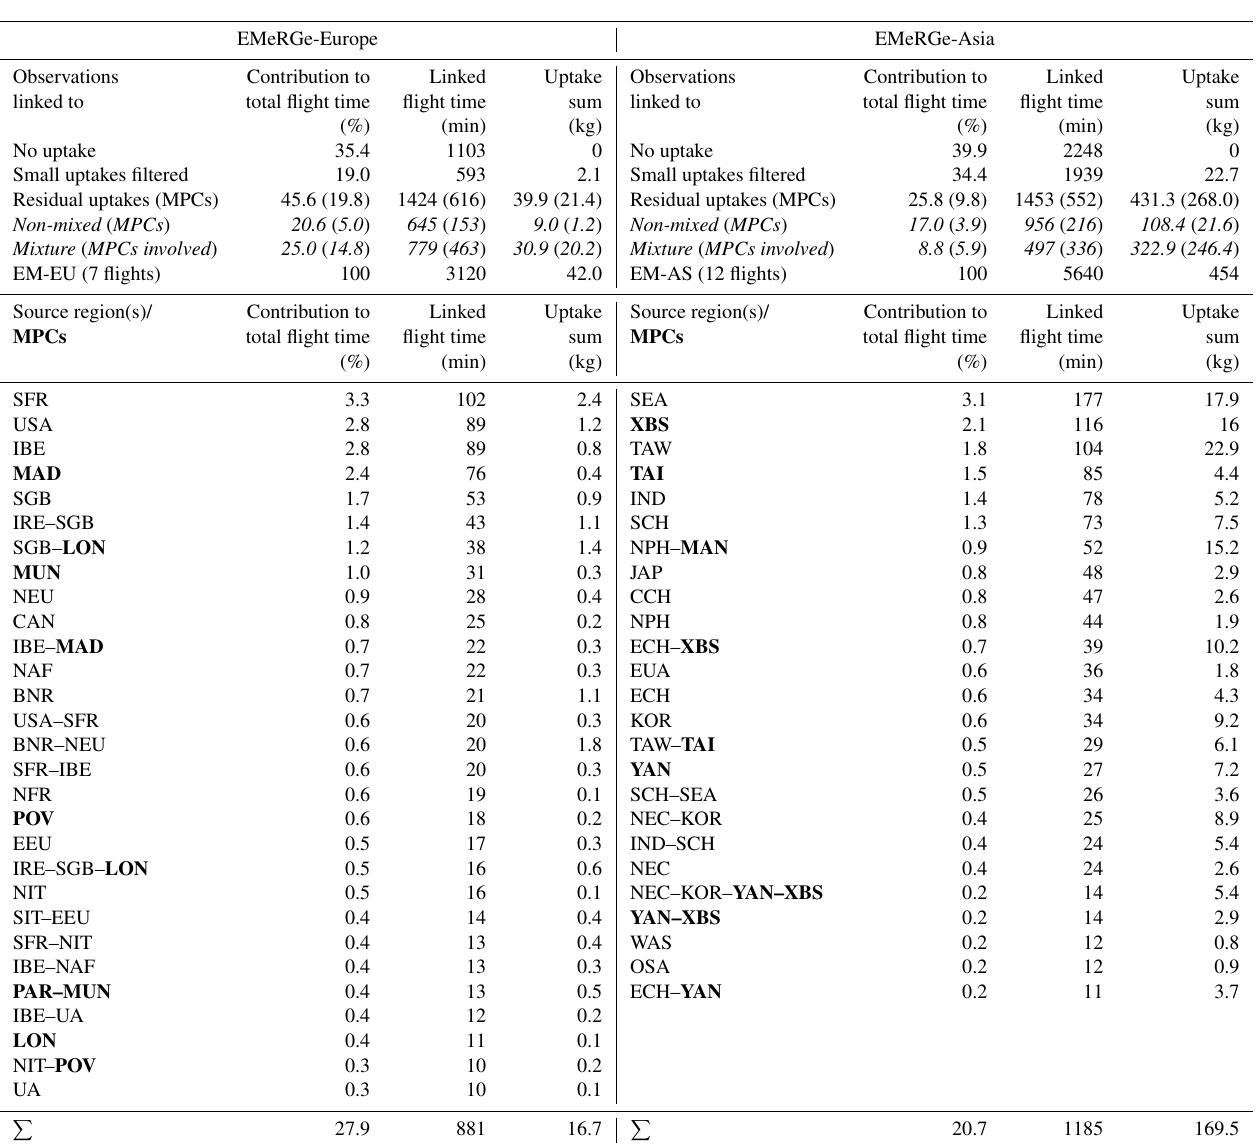
Table 5. Trajectory-based emission contributions from different source regions (left from EMeRGe-Europe, right EMeRGe-Asia), listed according to temporal frequency and magnitude (contribution in percentage, flight time in minutes, uptake sum in kilogram). Mixtures (of significant uptakes) from different source regions are indicated by en dashes, e.g. “IRE–SGB”. MPCs are highlighted with bold letters. Small uptakes, in sum 5% of the total modelled uptake sum of the respective campaign part, and contributions of less than 10min flight time are omitted. The upper part indicates the overview (sums) of both campaigns. Residual uptakes are divided into non-mixed and mixed, indicated by italics. MPC contributions are given in brackets. For full names of source regions see Table